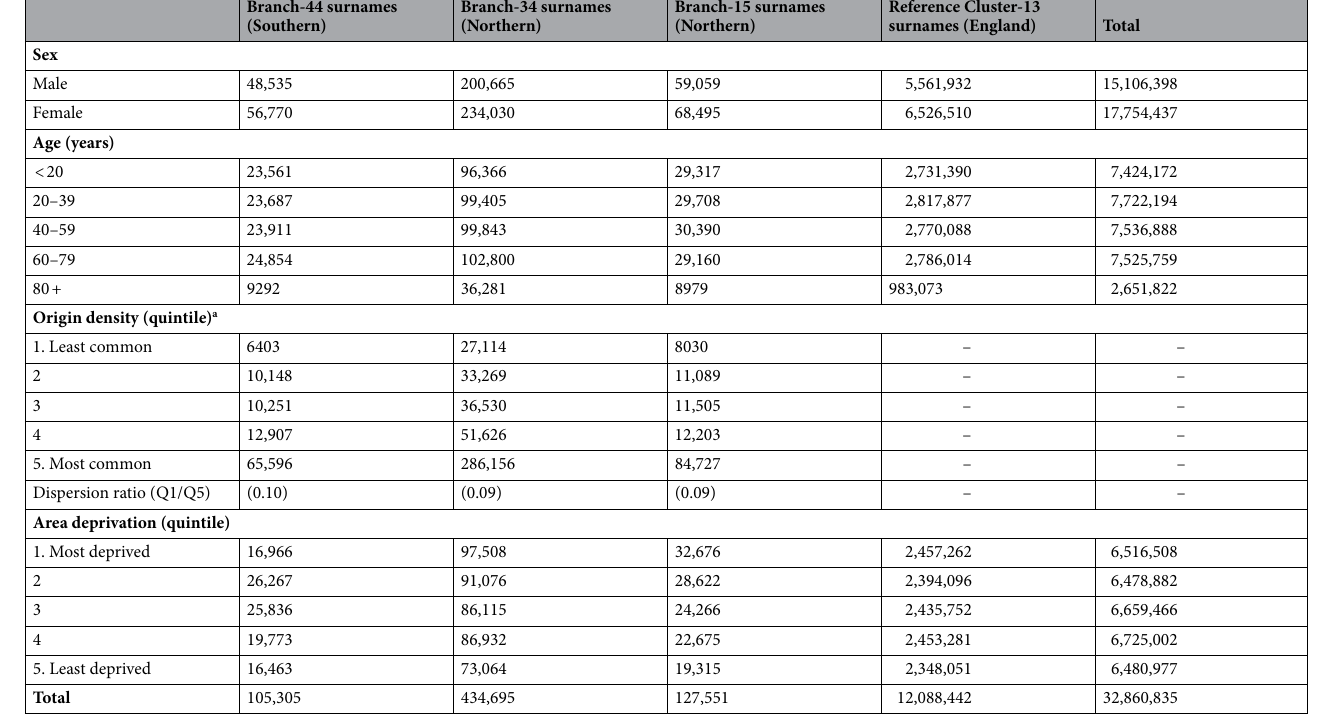
Table 1. Patient denominator characteristics by signal set surname origins, reference surname origin (Cluster-13), and total First admission of any kind in patients with British surnames in Hospital Episode Statistics (HES) in England between 1999 and 2013. a Origin density is specific to the signal and not shown for reference population and totals